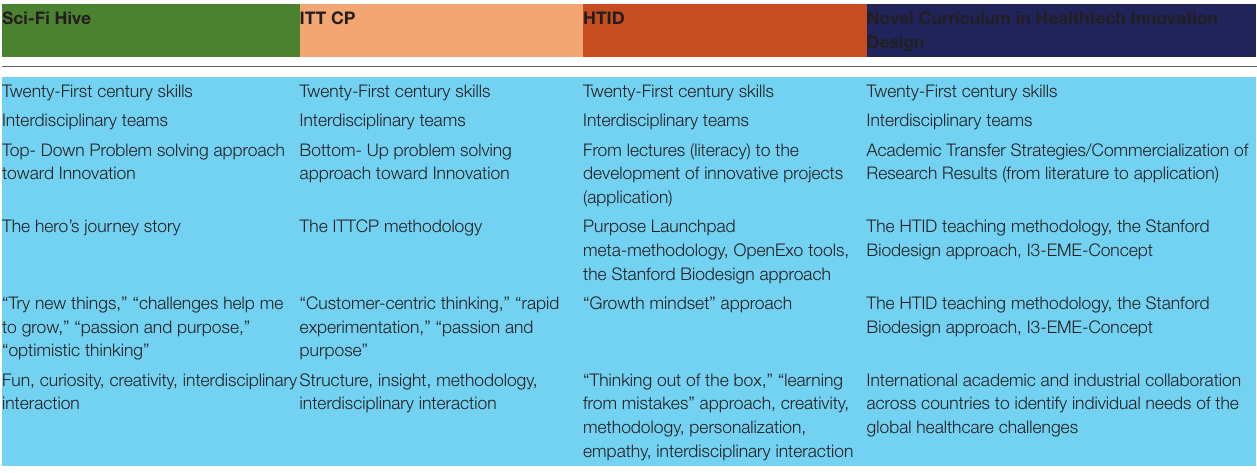
TABLE 2 | Summary of the learned skills from the different educational programs—Sci-Fi Hive, ITTCP, HTID—needed to formulate the novel curriculum in Innovation Tech Design. Sci-Fi